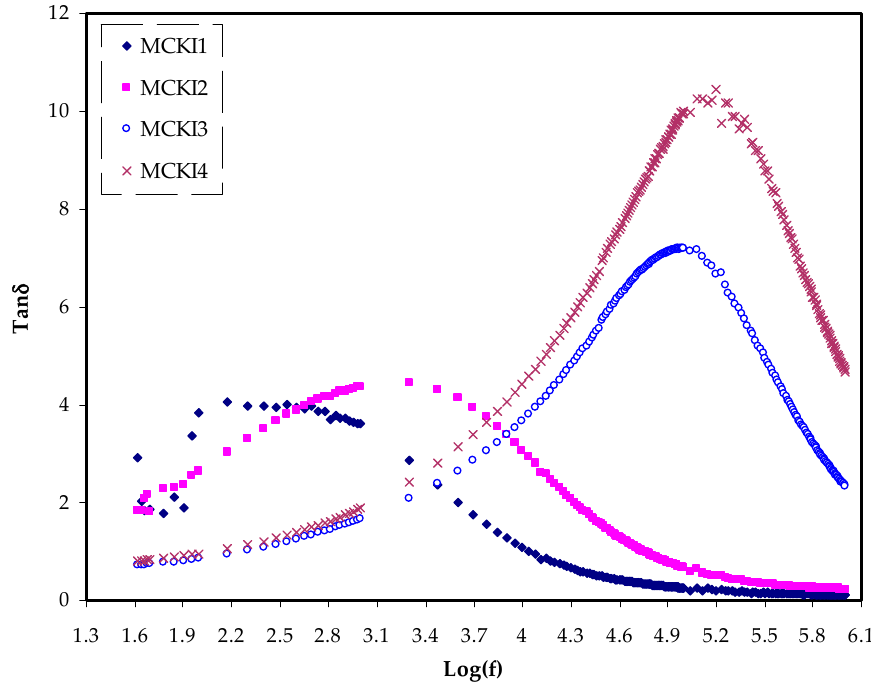
Figure 5. ( tan δ ) spectra versus frequency at room temperature for the MCKI Figure 5. (tan δ ) spectra versus frequency at room temperature for the MCKI electrolytes. The real, M r and imaginary, M i components of the electric modulus M* against fre-